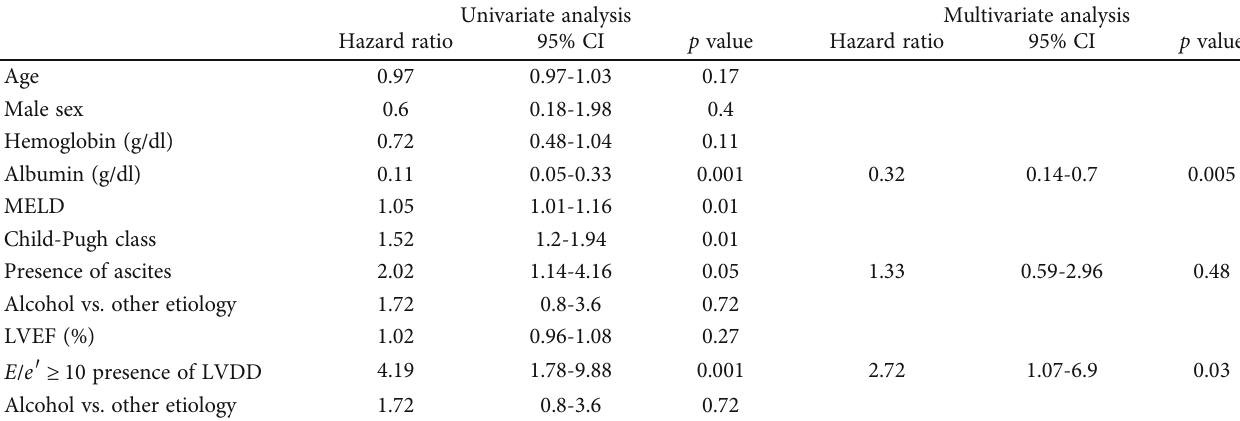
Table 5: Cox regression model for predicting survival in patients with decompensated